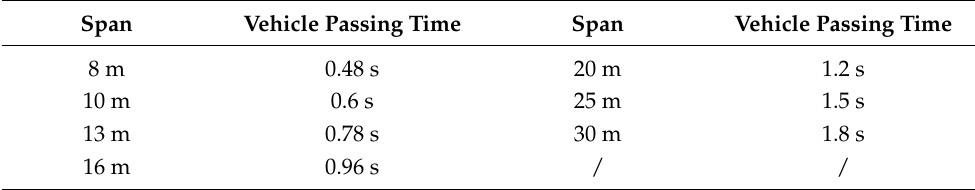
Table 4. The time it takes for vehicles to pass over bridges of different spans (unit: seconds). Span Vehicle Passing Time Span